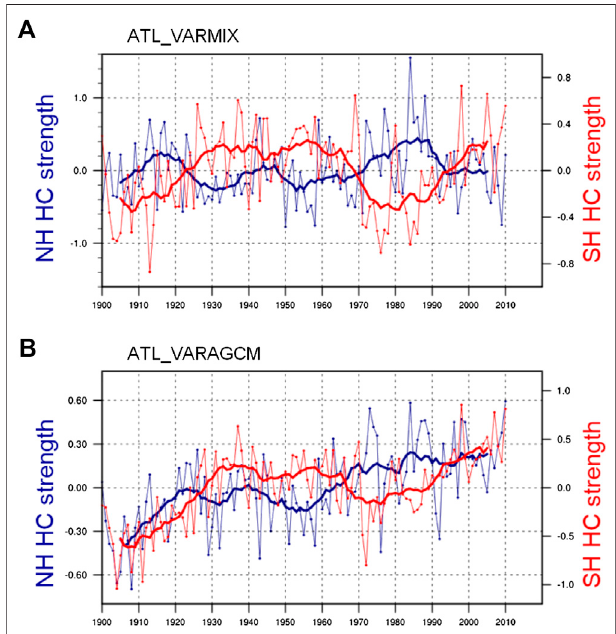
FIGURE 5 | Time series of the raw (thin lines) and decadal component (thicklines)oftheHCstrengthindices(10 9 kg s − 1 )intheNH(bluelines)andSH (red lines) from the (A) ATL_VARMIX and the (B) ATL_VARAGCM experiment for 1900 – 2010.